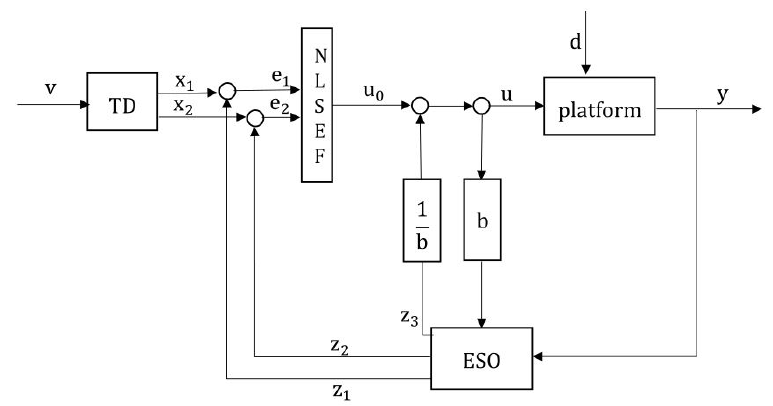
Figure 4. Second-order ADRC system.